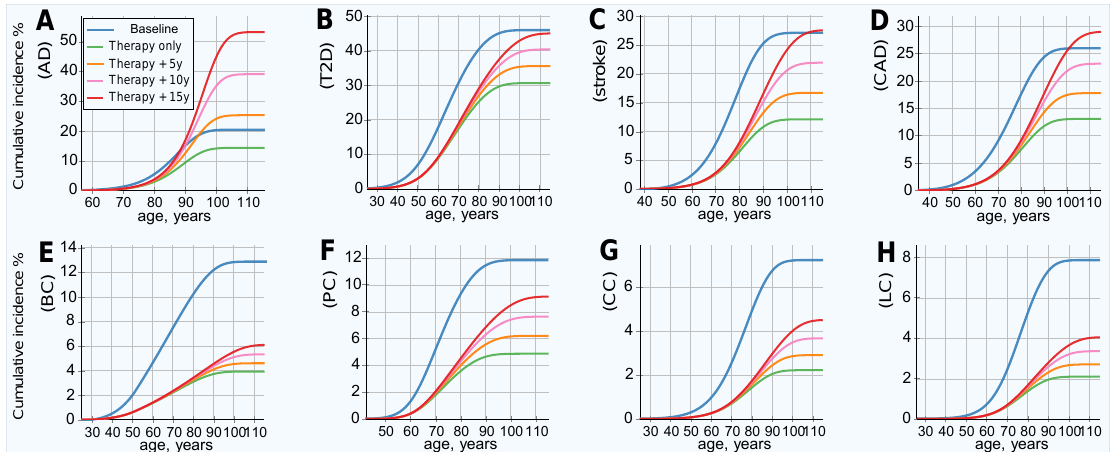
Figure 4. Cumulative incidence and lifetime risk following therapy reducing the population risk fourfold. ( A ) Alzheimer’s disease, ( B ) type 2 diabetes, ( C ) cerebral stroke, ( D ) coronary artery disease, ( E ) breast cancer, ( F ) prostate cancer, ( G ) colorectal cancer, and ( H ) lung cancer. All individuals in the population had emulated corrective gene therapy editing of, on average, 15 SNPs (corresponding to an OR multiplier of 0.25). Result of gene therapy and results in increases in life expectancy of 5, 10, and 15 years. Lifetime risk (lifetime cumulative incidence) corresponds to the lifetime (rightmost) values of the